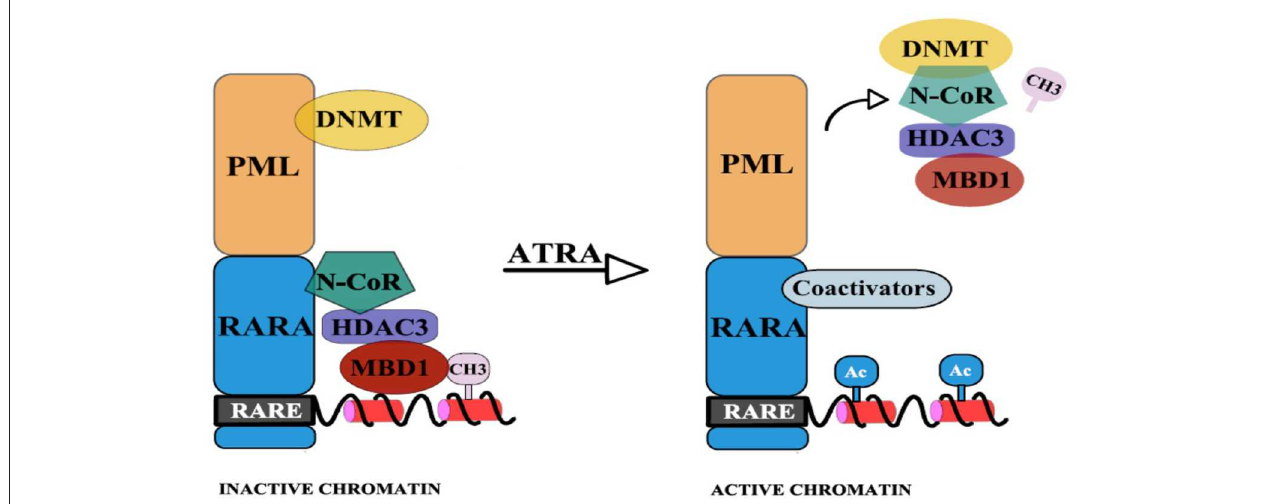
FIGURE 2 | PML-RARA, through its PML moiety establishes interactions with DNMTs. Newly methylated CpGs are used as “docking sites” for MBD1 which can also recruit other corepressors. The RAR moiety interacts with the nuclear corepressor N-CoR, which further recruits HDAC3. HDAC3 can also interact with the TRD of MBD1. This results in hypoacetylation, DNA methylation, and subsequent gene silencing. Upon ATRA treatment, the stable complex is disassembled and coactivators (with histone acetyltransferase activity) are recruited